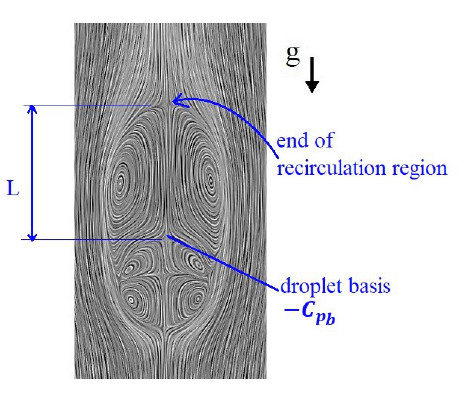
Figure 11. An example of time-averaged flow over a droplet, showing the position for the base pressure coefficient − ¯ C pb and wake recirculation